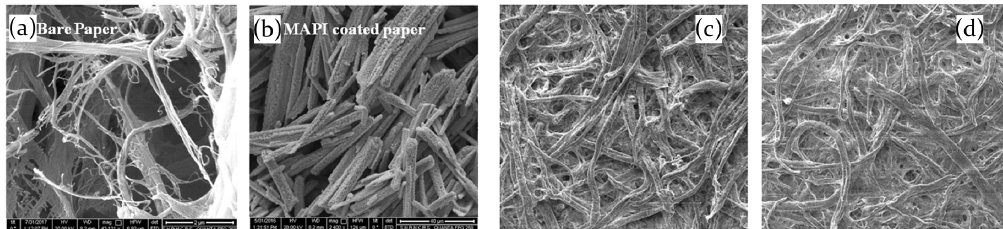
Figure 10. Field emission scanning electron microscope (FESEM) images of ( a ) bare paper and ( b ) MAPbI 3 -coated paper: perovskite exploits the fibril structure of the paper substrate to grow with a nanorod-like structure. FESEM images of ( c ) PbI 2 and ( d ) MAPbI 3 after NH 3 exposure: the morphology of the MAPbI 3 film after interacting with ammonia looks like PbI 2 film more than the pristine perovskite film. Adapted with permission from [80], under the terms of the Creative Commons Attribution 4.0 International License. Copyright © 2018, Springer